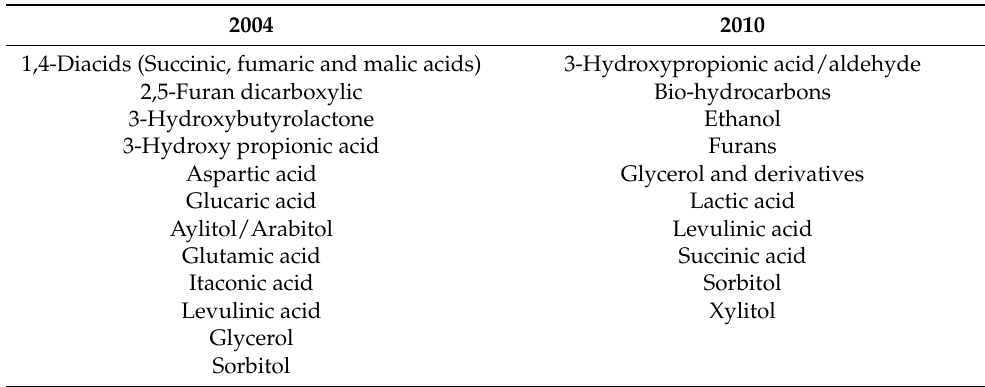
Table 1. The 2004 and 2010 “revisited” US Department of Energy’s top Sugar-derived Building Block Chemicals